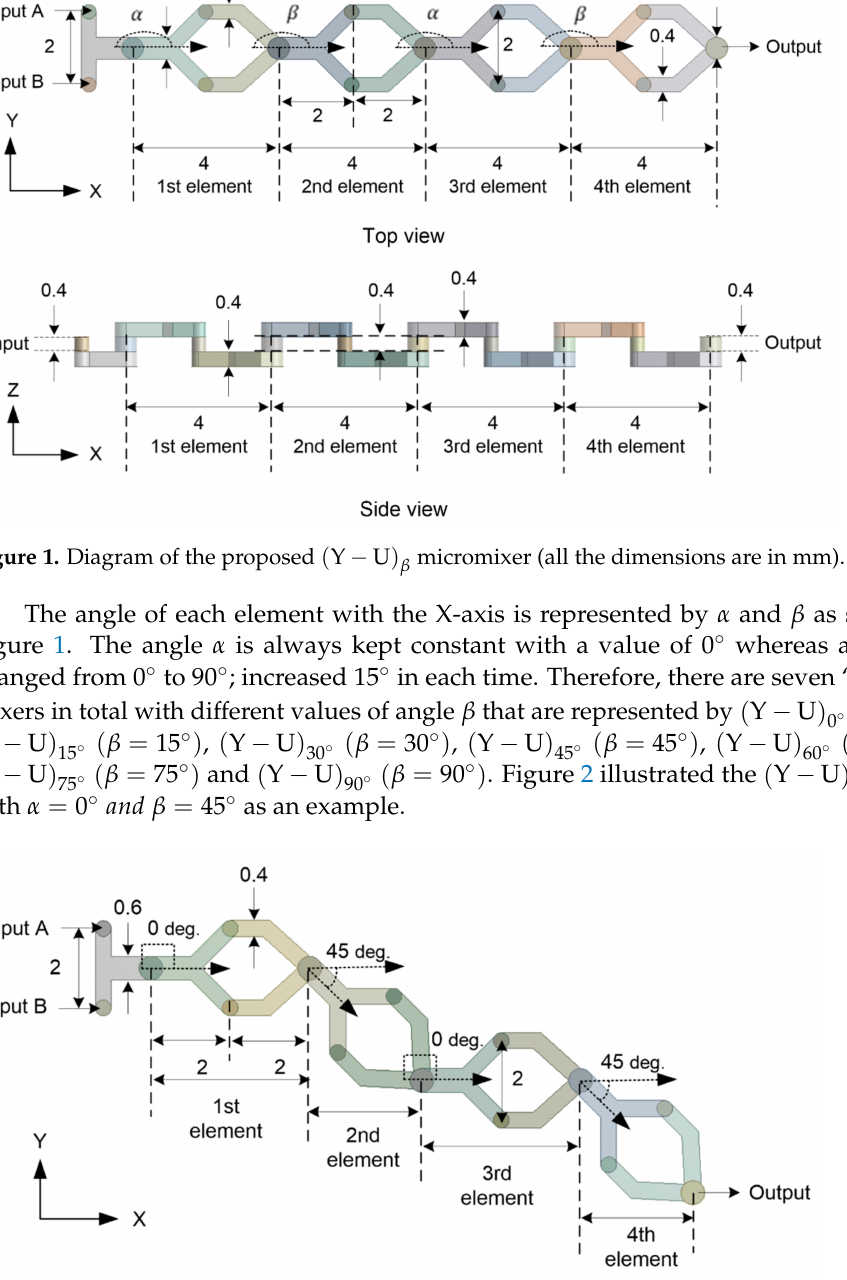
micromixer (all the dimensions are in 45 ◦